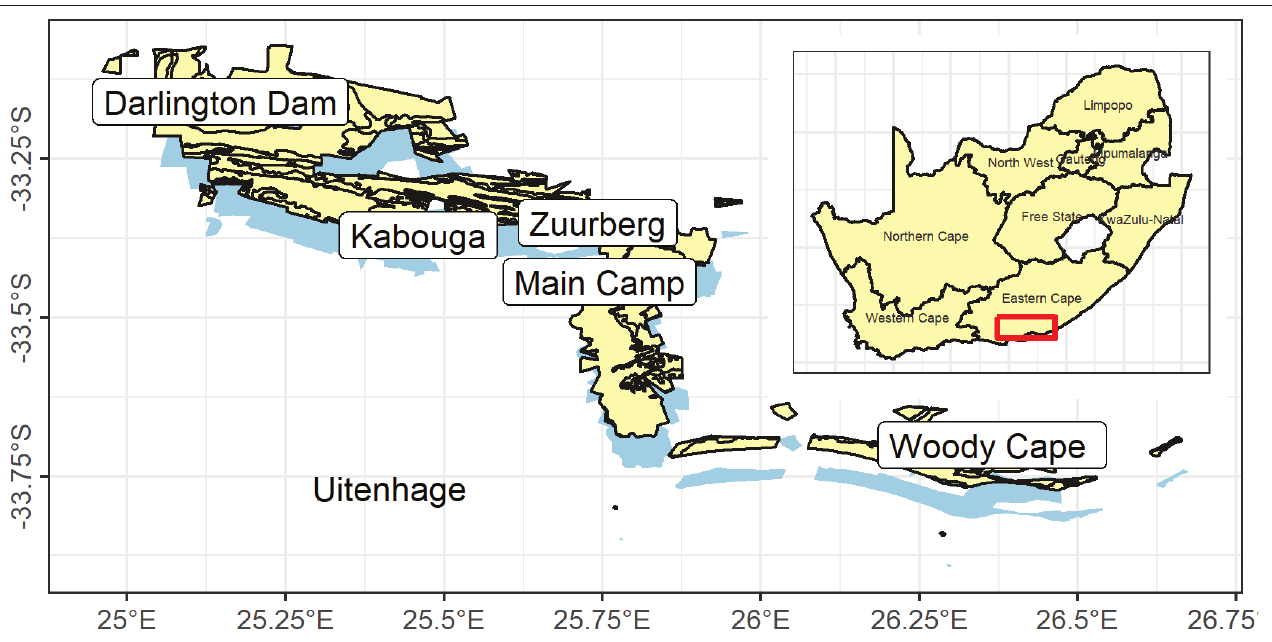
FIGURE 1: Map of South Africa, showing the locality of the Addo Elephant National Park in the Eastern Cape province (inset) and the different sites where spiders were